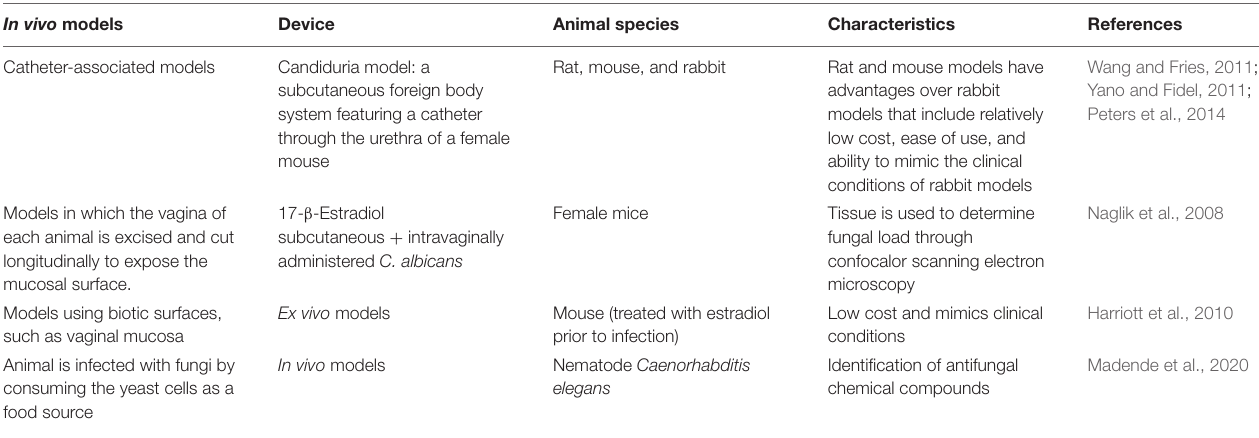
TABLE 4 | Schema for in vivo/ex vivo Candida -associated urogenital biofilm models. In vivo